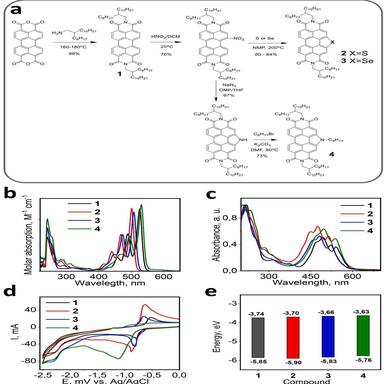
Synthesis of perylendiimide derivatives 1–4 (a), UV-VIS spectra of 1–4 in CHCl3 solutions (b) and thin films (c), cyclic voltammograms of 1–4 films deposited on glassy carbon electrode vs Fc+/Fc in 0.1 M solution of n-Bu4NPF6 in acetonitrile as supporting electrolyte at a scanning rate of 50 mV s − 1 (d), the frontier energy level diagrams for compounds 1–4 (e).